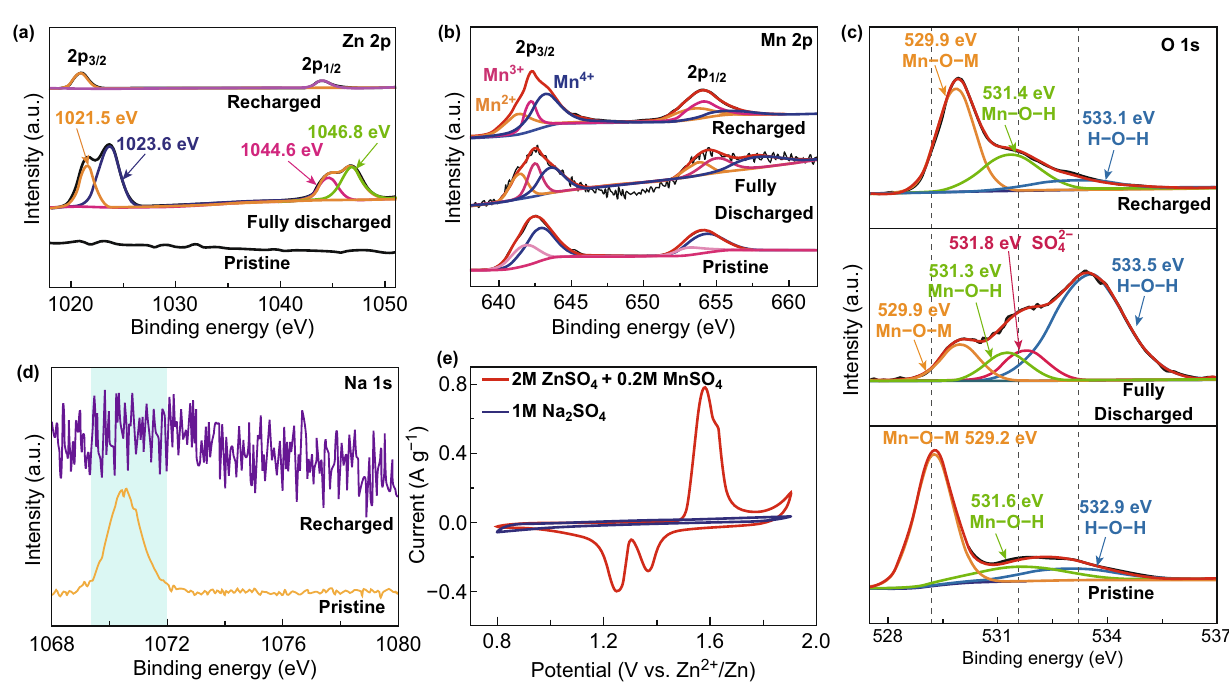
Fig. 5 High‑resolution XPS spectra of a Zn 2 p , b Mn 2 p , and c O 1 s at initial, fully discharged, and charged statuses. d XPS Na 1 s spectra at different statuses of initial and after recharged to 1.9 V. e Cyclic voltammetry curves of the coin‑type Zn/NMOH cell at 0.1 mV s −1 using aque‑ ous electrolytes of 2 M ZnSO 4 + 0.2 M MnSO 4 (red) and 1 M Na 2 SO 4 (blue). (Color figure